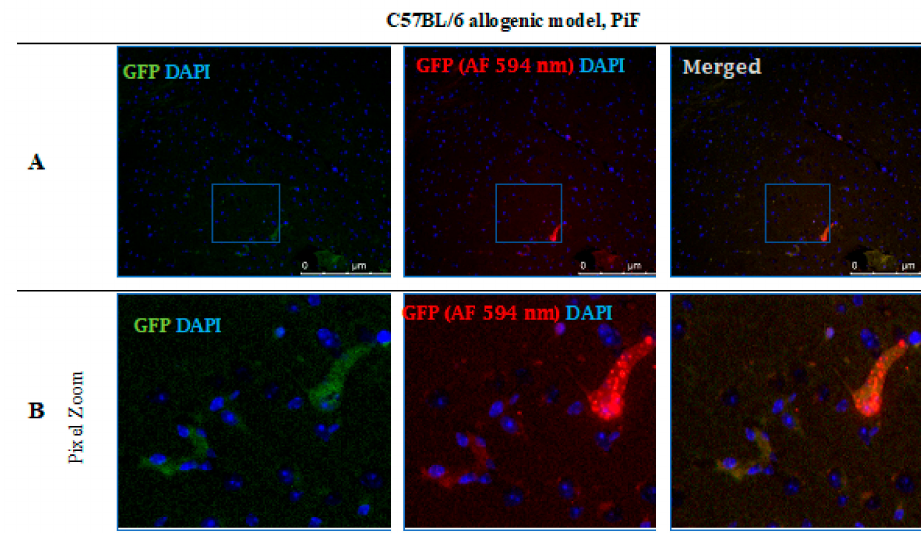
Figure 12. Post-mortem evaluation of GRPs’ graft localization. Immunohistochemical staining in the brain of C57BL/6 (allogeneic) mouse model after 14 days of observation in the group where PiF was applied: The GFP+ cells (green) were observed in the midbrain tissue. We used an anti-GFP antibody (secondary antibody pertaining to red fluorescence Alexa Fluor 594 nm, Abcam, Cambridge, UK) to assess if the signal is specific ( A , B ). Abbreviations: GFP-green fluorescent protein; GRP-glial-restricted progenitor cell; PiF-preimplantation factor.